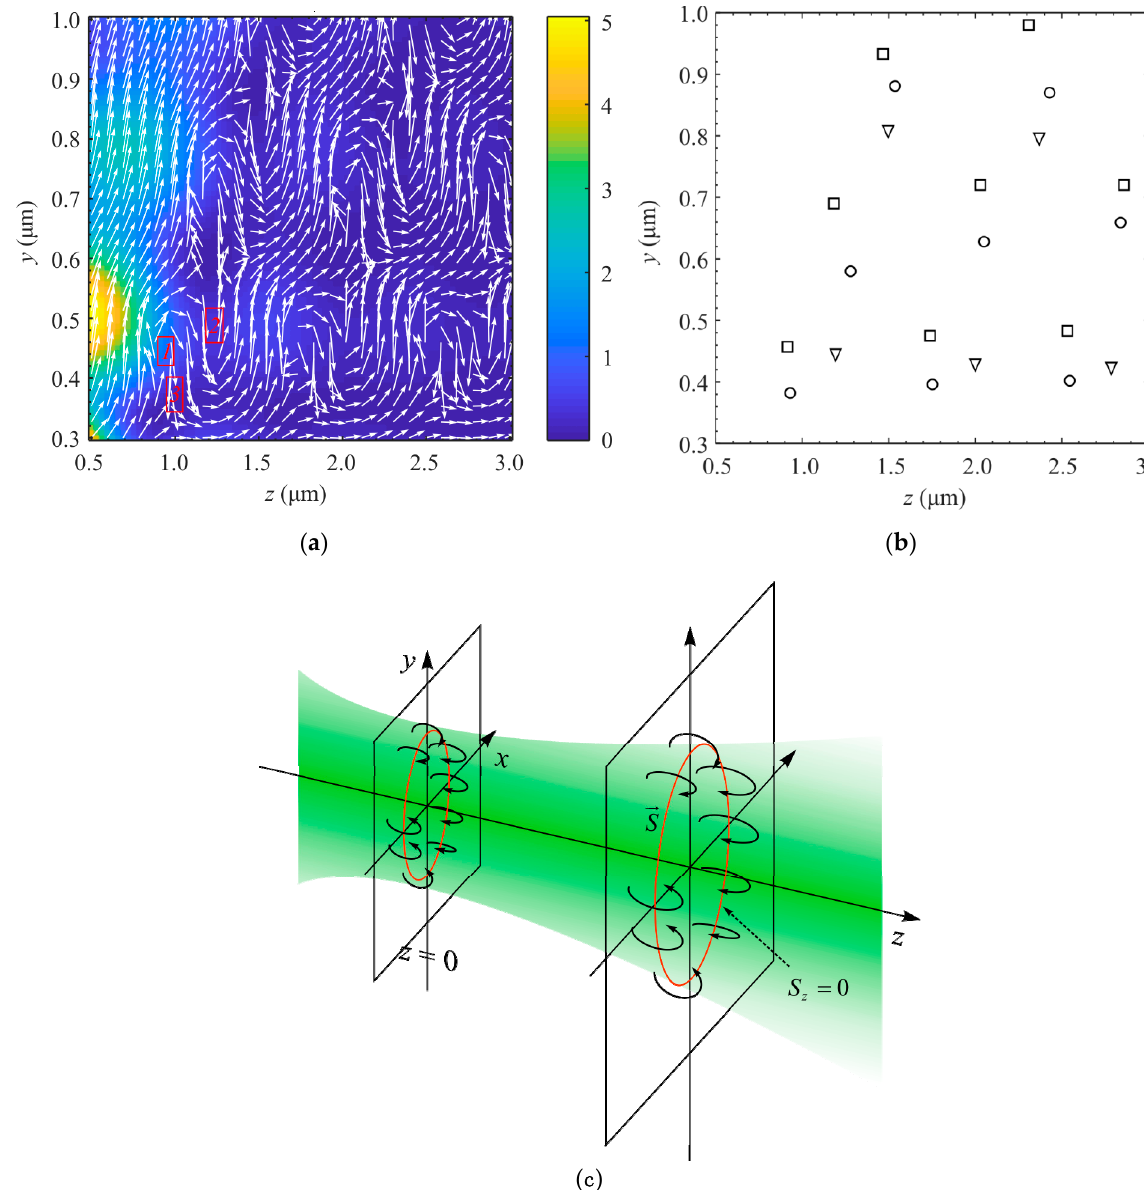
Figure 2. Intensity and direction of the Poynting vectors in the YZ-plane of the focused CVB of second order using a lens with numerical aperture NA = 0.99, limited by a narrow annular aperture with α min = 0.9 × α max .